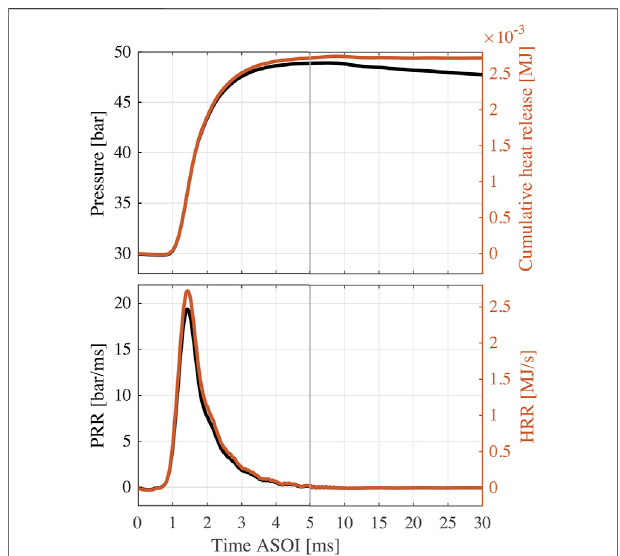
FIGURE 3 | Results of EN590 diesel as a function of time ASOI (two different scales are used to show results in 0 – 5,5 – 30 ms, respectively). Top: pressureandcumulativeheatreleasepro fi les.Bottom:PRRandHRRpro fi les. Test conditions: T wall = 580 ° C, P init = 30 bar, P inj = 1,500 bar, τ dur = 1.5